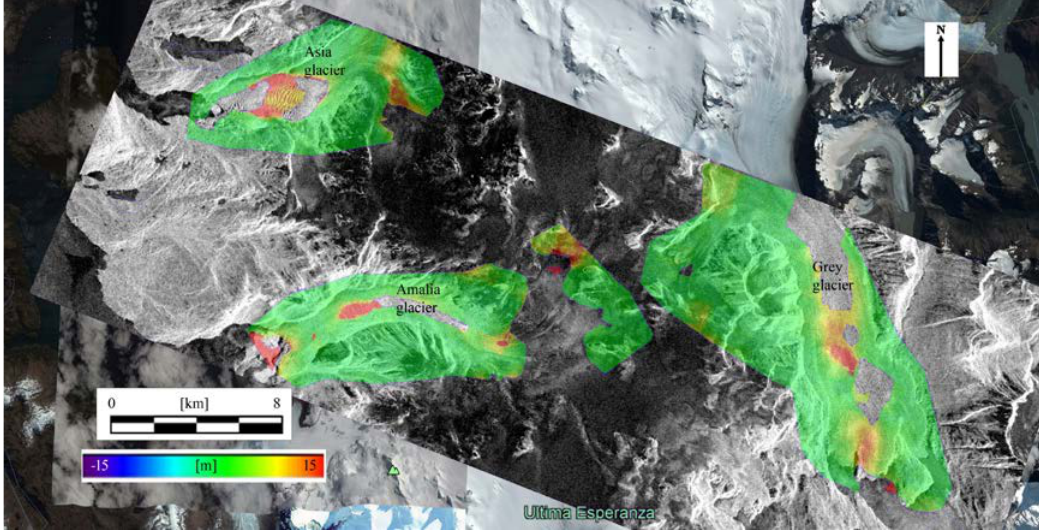
Figure 5. Displacement map superimposed to a geocoded amplitude and an optical image of Google